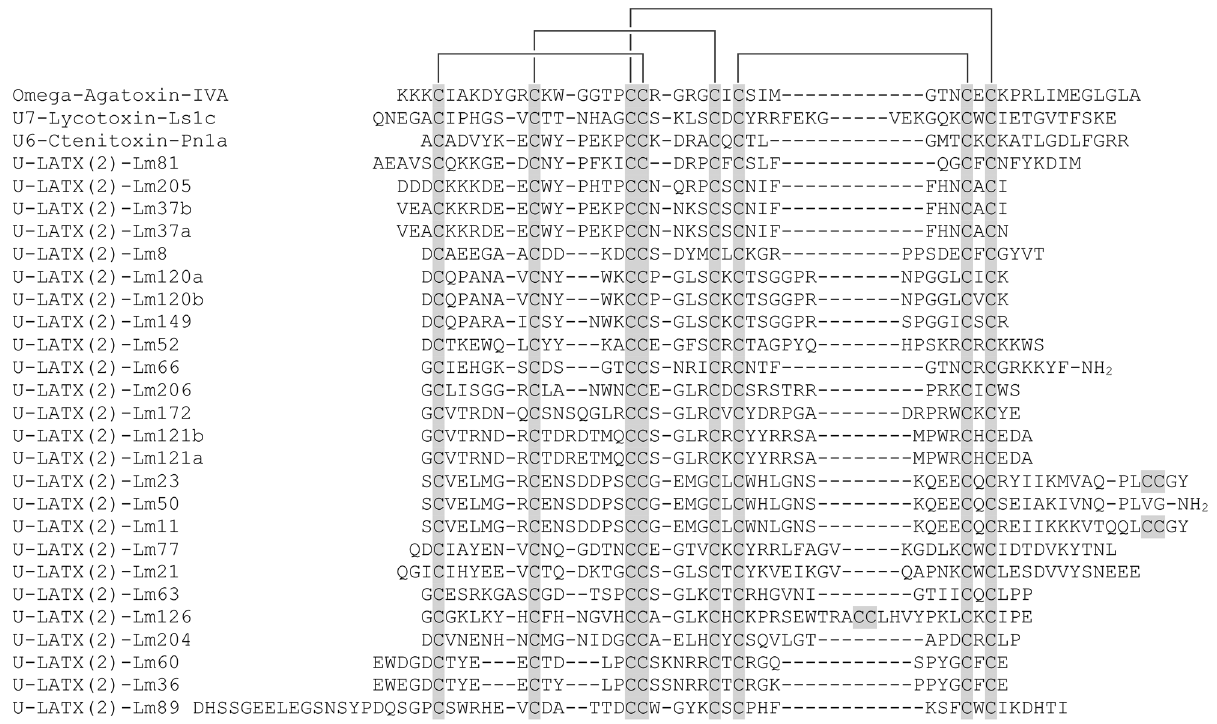
Figure 5. Sequence alignment of peptides in lampotoxin Family 2 and the three closest BLAST matches. Cysteine residues are highlighted in grey. Preferred prey (spider) Alternative prey (cricket) Spider species LD 50 (nl/mg) ED 50 (nl/mg) LD 50